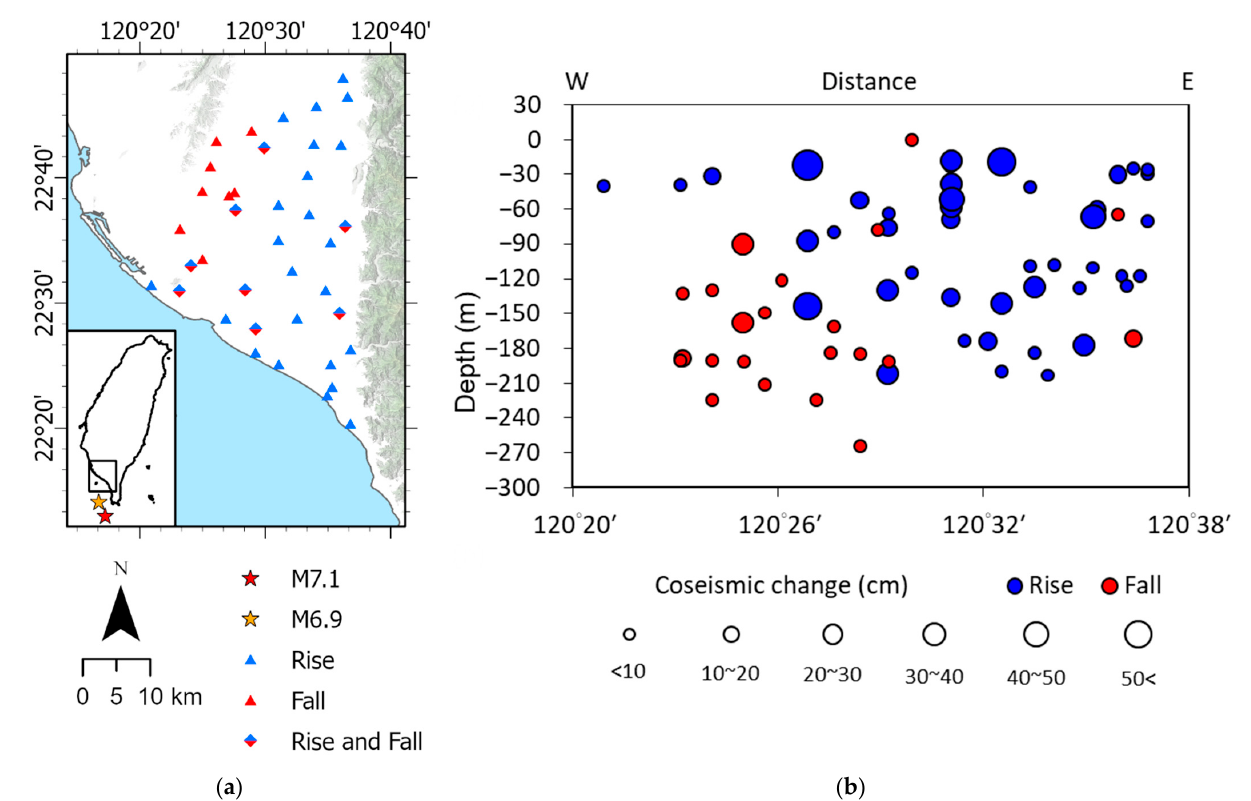
Figure 8. ( a ) Regional distribution of coseismic groundwater-level changes induced by the 2006 M7.1 and M6.9 earthquake doublet in the southern plain of Taiwan; ( b ) vertical distribution of the coseismic changes along the east–west profile.